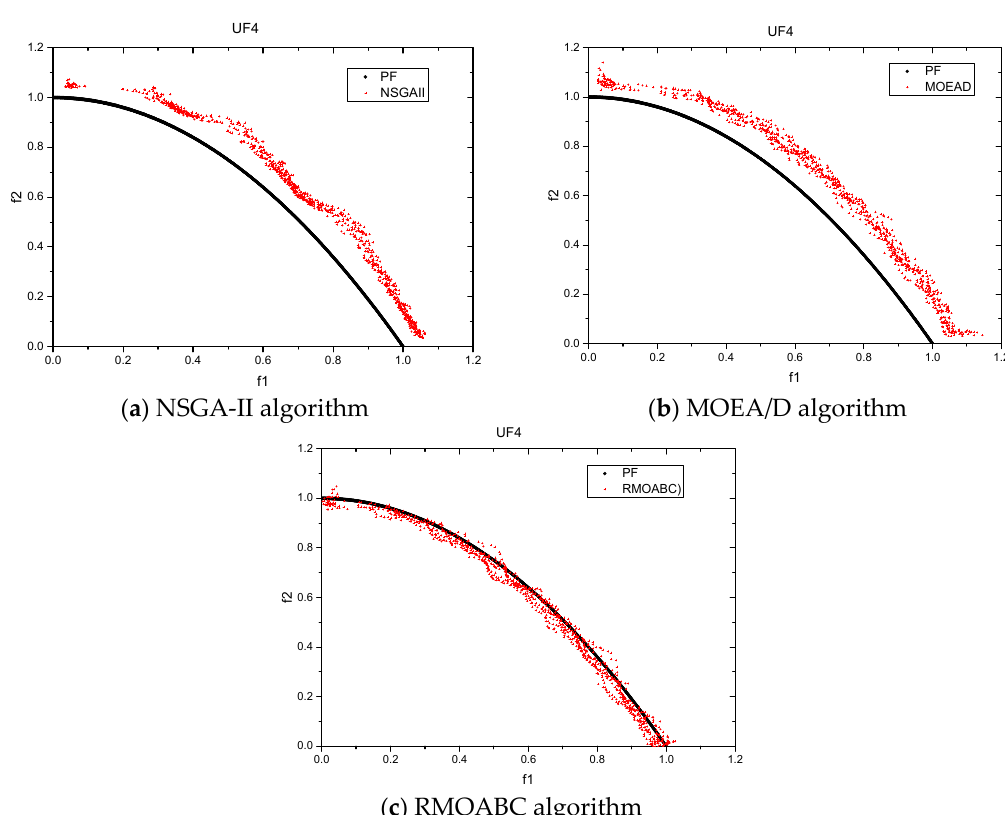
Figure 7. Plots of the non-dominated front found by the three algorithms for 2-objective UF4 test